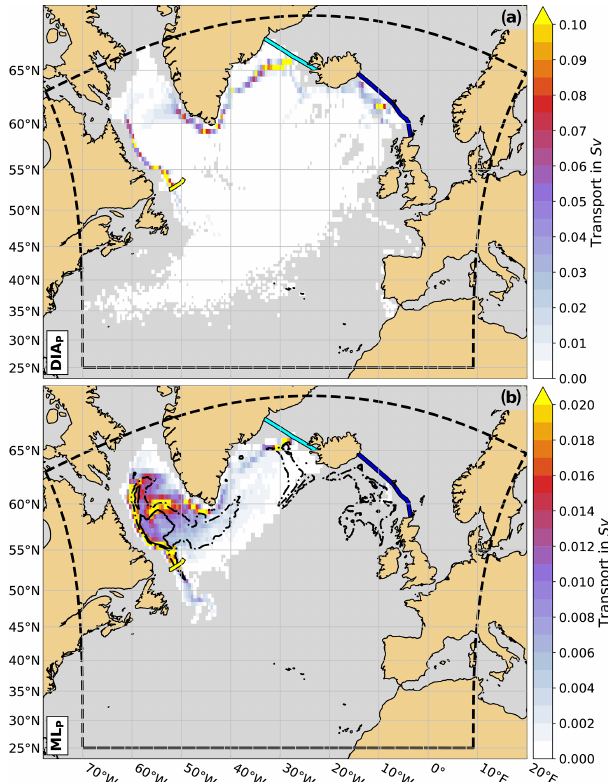
Figure 4. Locations of origin, calculated as mean transport (in Sv, shading, 1 / 2 ◦ × 1 / 2 ◦ bins) for (a) DIA P and (b) ML P (see Sect. 2.1.3 for details of the definitions). (b) The solid black contour marks the 2000–2019 mean December–January–February–March (DJFM) mixed-layer depth of 500m. The dashed–dotted black con- tour marks the 2000–2019 mean of the annual maximum mixed- layer depth of 500m. The period 2000–2019 is chosen to capture the period where the vast majority of ML P is circulating. The yel- low line marks the 53 ◦ N section, and the light and dark blue lines mark the Denmark Strait and Iceland–Scotland Ridge sections, re- spectively. The dashed black line indicates the boundary of the ex- periment